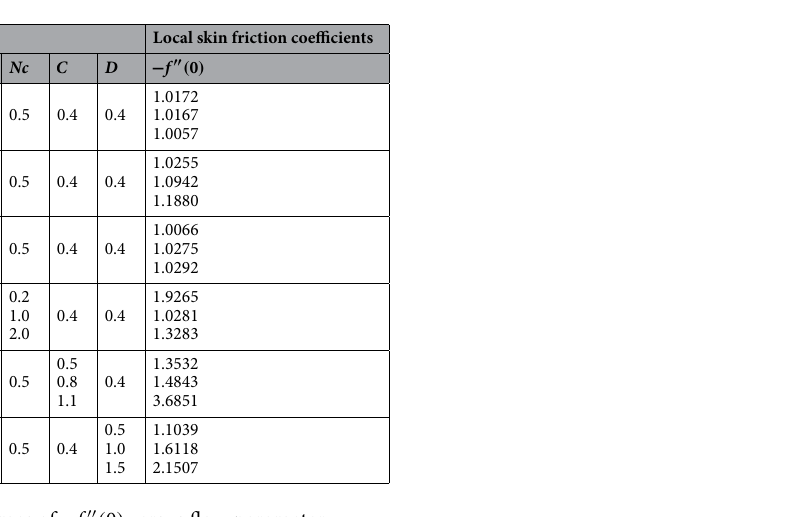
Table 1. Outcomes of